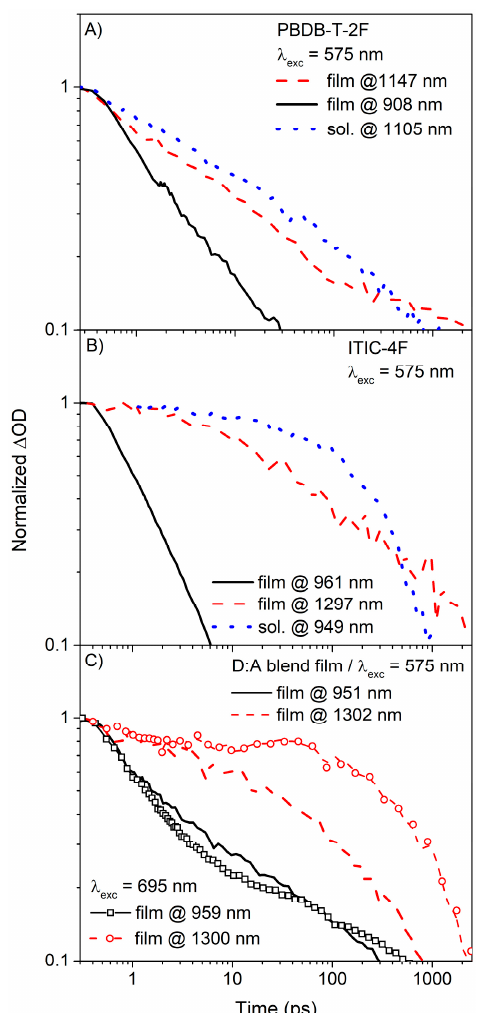
Figure 6. Normalized Δ OD kinetic traces of the ( A ) P pristine film, ( B ) I pristine film, and ( C ) P : I blend films. For ( A , B ), the excitation wavelength was 575 nm. For ( C ), the kinetic traces of Δ OD with excitation wavelengths of both 575 nm and 695 nm (curves with markers) are shown for comparison.